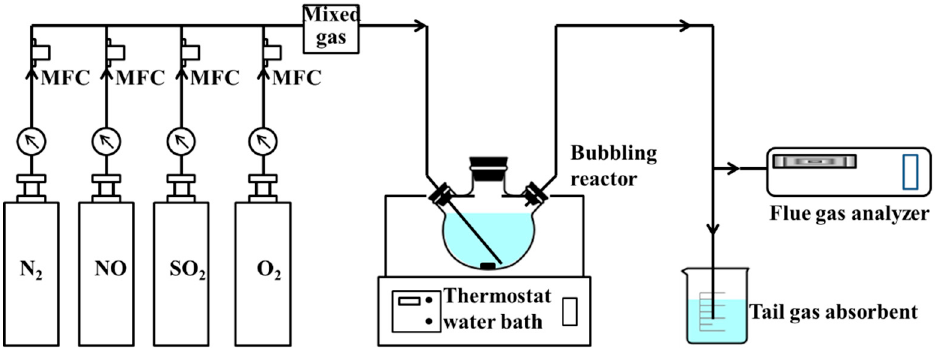
Figure 1. Schematic diagram of the experimental apparatus.